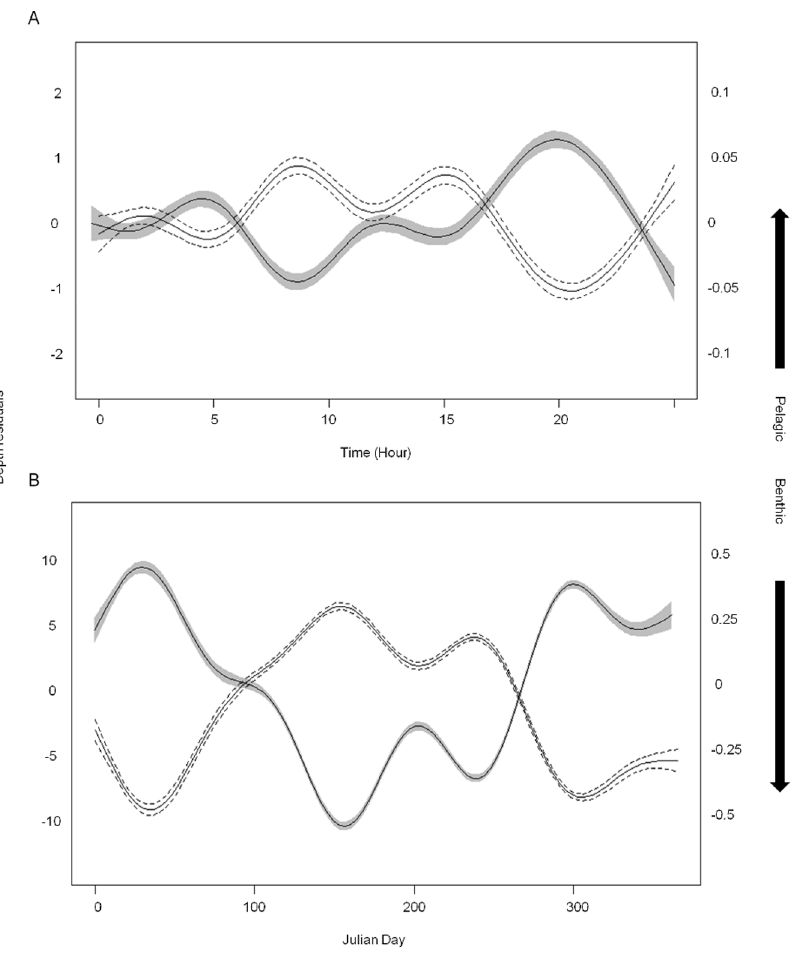
Figure 7. Passive telemetry: modelling of seasonal shifts in behaviour. Partial coefficients of Depth (black line - shaded 95% CI) and Behavioural State (black line - dashed 95% CI) as a function of (a) minutes across 24 hours and (b) daily values over 365 days from GAM models. The patterns show a strong positive correlation (r . 0.9) such that when the fish are at deeper depths they are more likely to occupy a benthic state and vice versa.